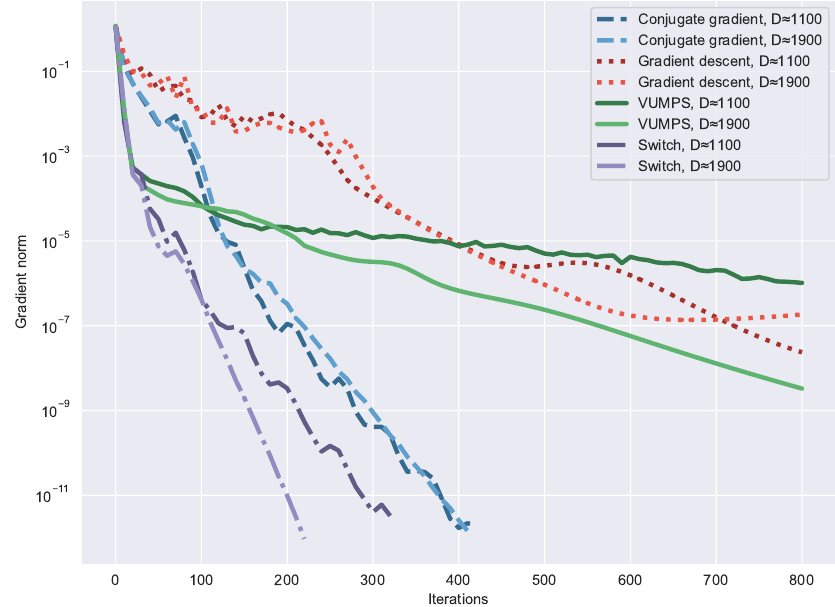
Figure 3: A comparison of convergence in optimising an infinite MPS using VUMPS (solid green lines), conjugate gradient (dashed blue lines), gradient descent (dotted red lines), and the “switch” method that combines VUMPS and conjugate gradient (dash-dotted purple lines). The benchmark model in question is a triangular lattice antiferromagnetic spin- 1 Heisenberg model on a cylinder of width 6. Results are 2 shown for MPS bond dimensions 1100 (darker colors) and 1900 (lighter